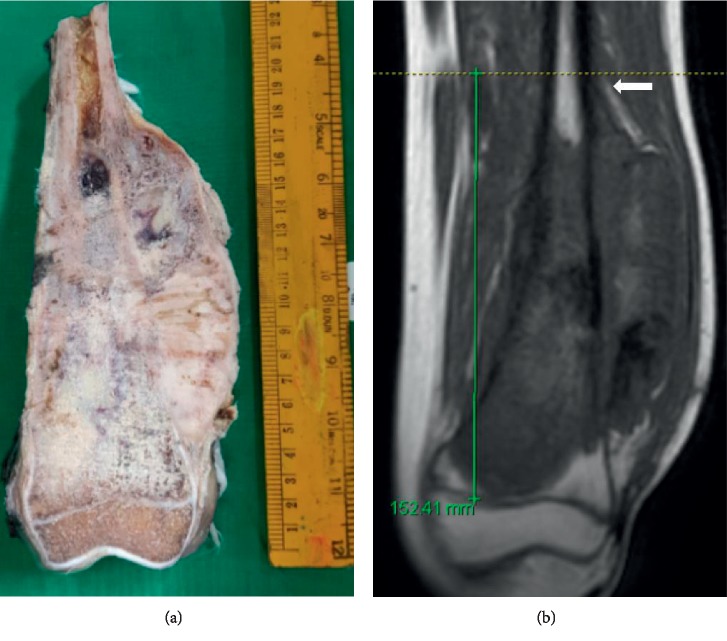
Tumor length measurements in the case of distal femur osteosarcoma on the gross specimen (a) 16.5 cm and noncontrast T1-weighted coronal MRI (b) 15.2 cm. Note that the white arrow indicates the periosteal reaction and soft tissue component exceed the intramedullary tumor extent.